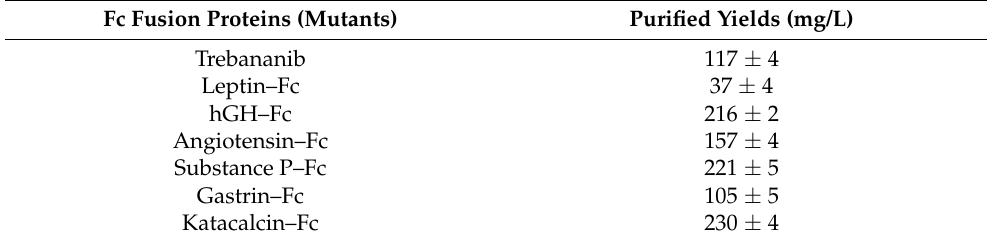
Table 2. Yields of mutant Fc fusion proteins (C250A, C308A) purified from 3 mL cultures (24 DWP). Fc Fusion Proteins (Mutants) Purified Yields